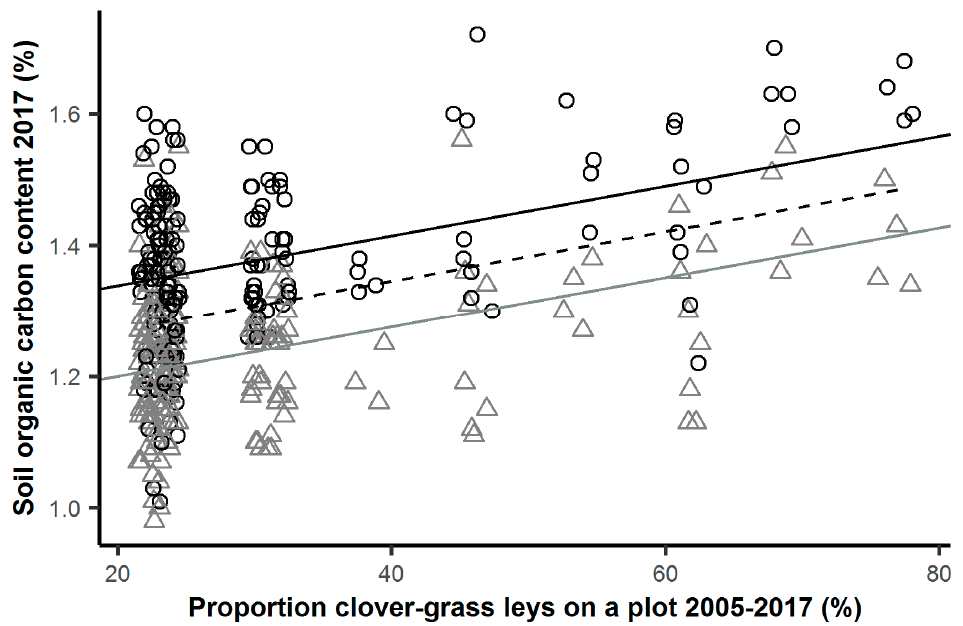
Figure 4. Correlation between the proportion of clover-grass leys on a plot in the period 2005–2017, and the SOCc (%) of that plot in 2017. Unfertilised plots are represented by grey triangles, fertilised plots by black circles. The dashed line is the combined regression line (y = 1.19 + 0.004x, R 2 = 0.13, p < 0.001, n = 379). The grey solid line is the regression line for the unfertilised plots (y = 1.13 + 0.004x), the black solid line is the regression line for the fertilised plots (y = 1.26 + 0.004x), assuming no interaction between the proportion of clover-grass and fertilisation. Jitter was added to the proportion of clover-grass leys to improve visibility of symbols.